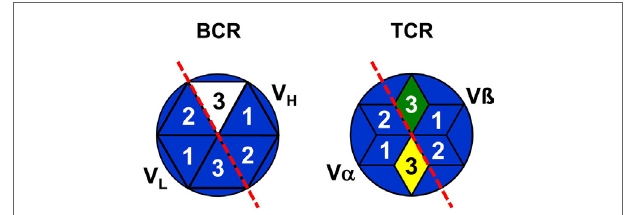
FiGURe 4 | Representation of B and T cells by top views of their antigen receptors. B cells are schematically represented by stylized top views of their BCR paratopes as hexagons [based on Ref. (96)] and T cells by hexagonal stars [based on Ref. (97)]. Numbers indicate the complementarity- determining regions 1–3 of V H , V L , TCR α , and TCR β . BCR/TCR background colors symbolize the specificity of a particular paratope just as the genomic coding of CDR1 and CDR2. The full nonself-quality of CDR3s is indicated by different colors, but the marginal nonself-character of CDR-L3 is not